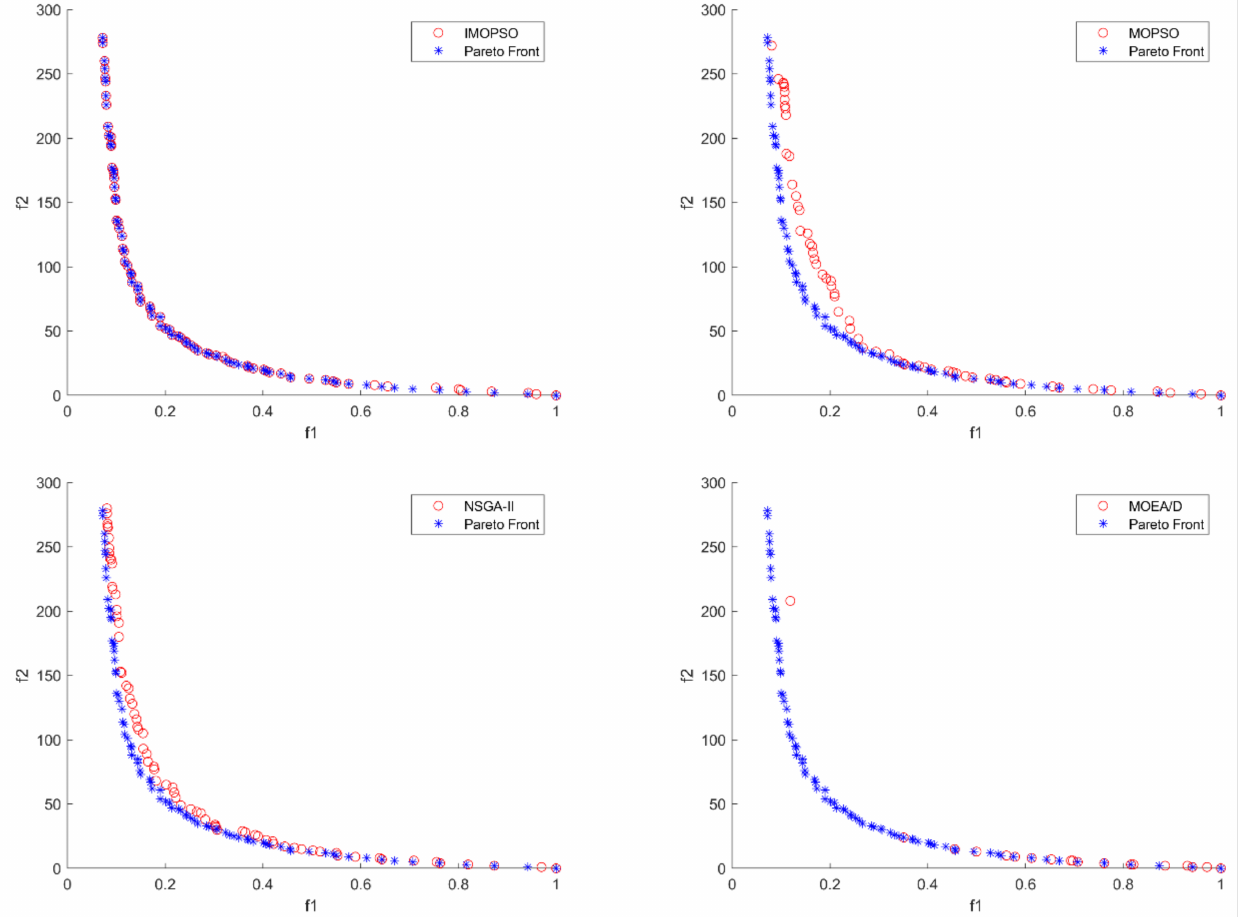
Figure 15. Pareto front produced by four algorithms on medium-scaled